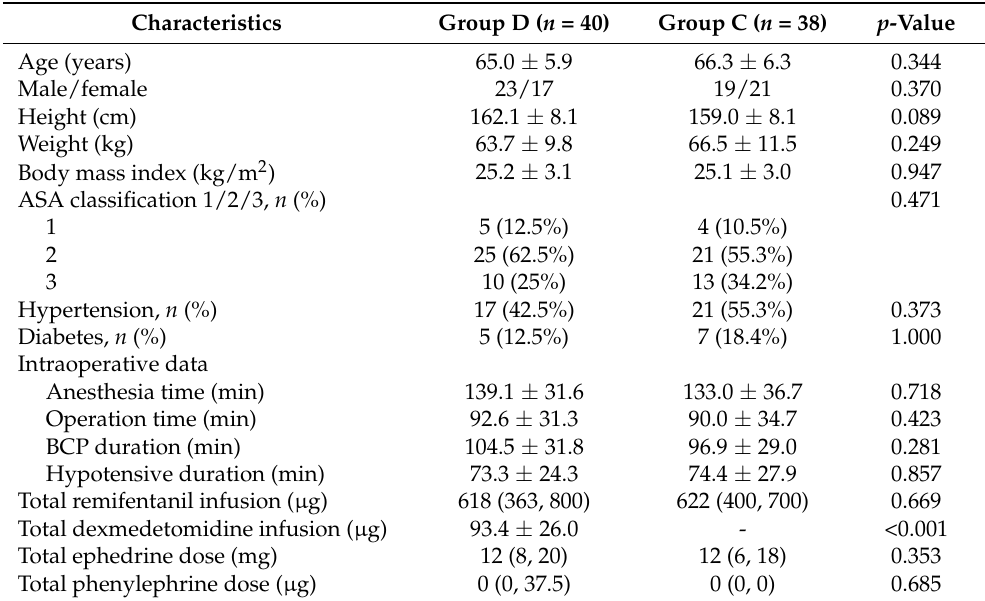
Data were presented as mean ± standard deviation, numbers (percentages) or median (interquartile range).